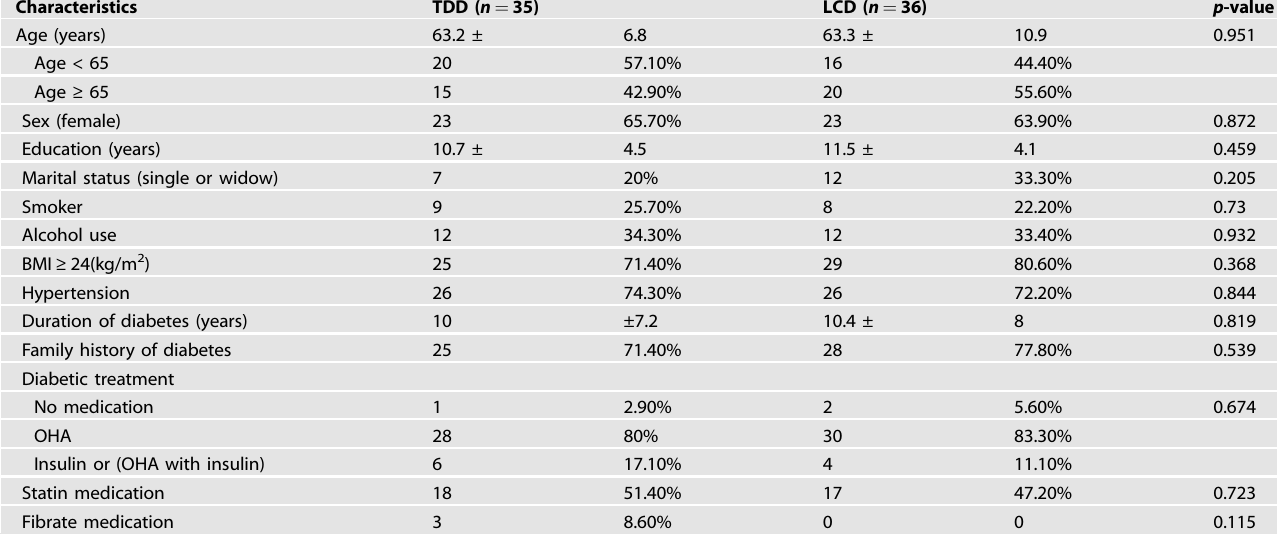
Table 1. Characteristic of the patients followed at one year after 18-month intervention trial. Characteristics